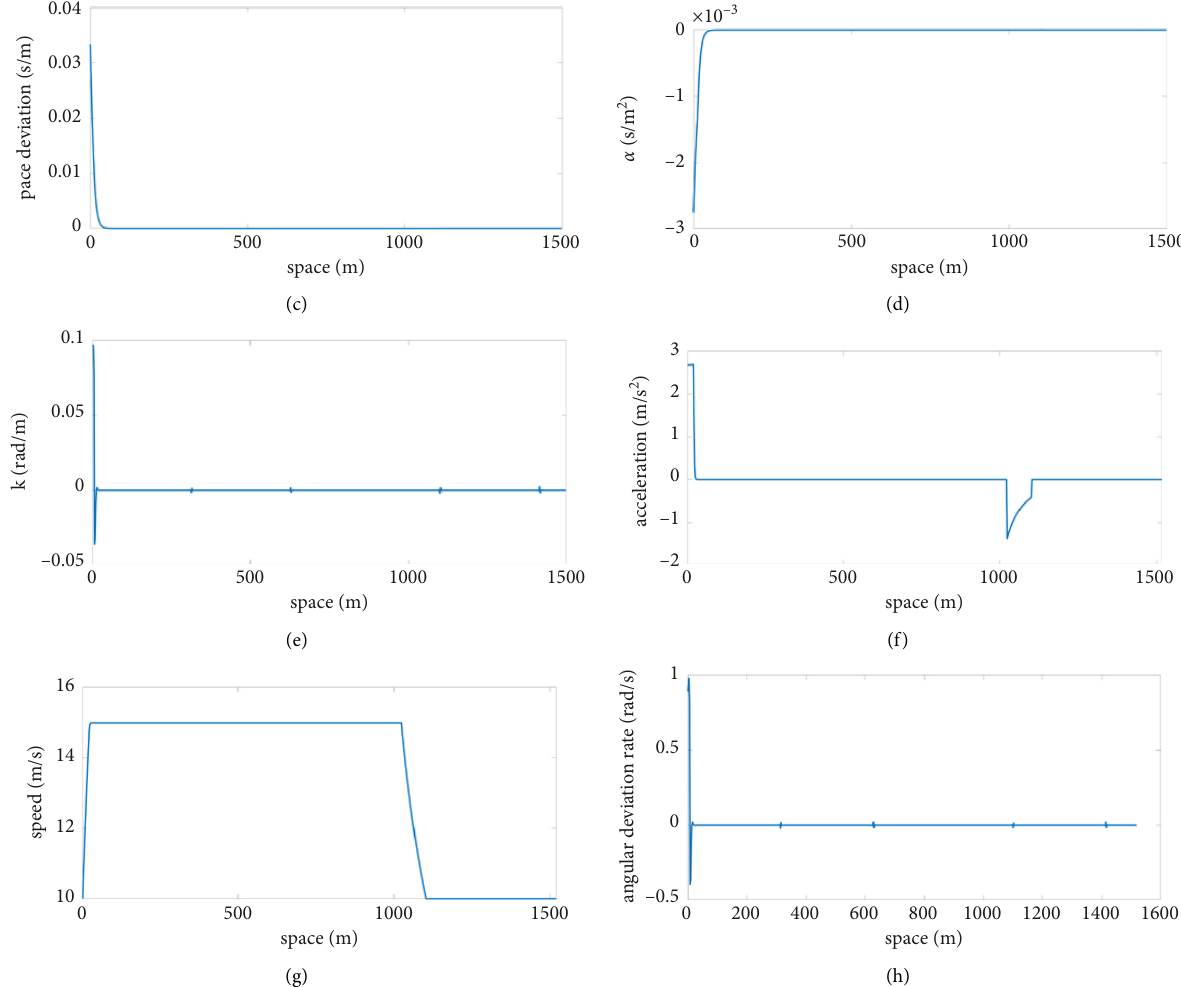
Figure 8: CAV state and control results with the “buffer zone”: (a) lateral deviation r ( s ) ; (b) angular deviation ψ ( s ) ; (c) pace deviation p ( s ) ; (d) relative moderation α ( s ) ; (e) relative angular spatial change rate k ( s ) ; (f) acceleration; (g) speed; (h) angular deviation rate.